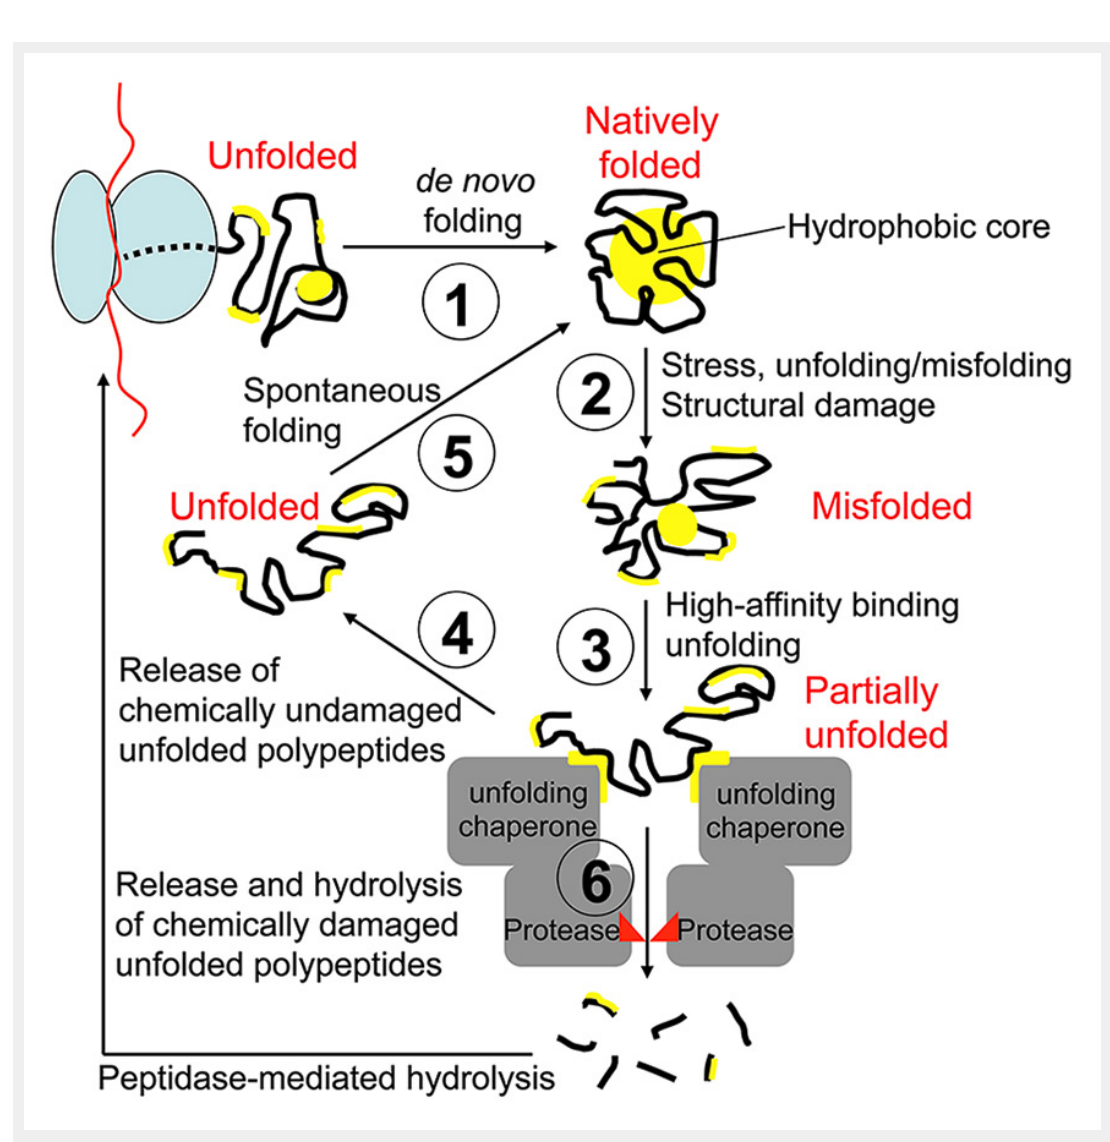
Proteins have an eventful life between birth on the ribosome and death by degradation . Nascent polypeptides with exposed hydrophobic residues (yellow) may spontaneously fold to the native state (step 1) with most hydrophobic residues forming a stable hydrophobic core. Stresses may cause their partial unfolding and misfolding with exposed hydrophobic residues (step 2) that can specifically bind (step 3) the hydrophobic surfaces (yellow) on unfolding chaperones (deep grey) and unfold. Following unfolding some polypeptides can be released (step 4) to spontaneously refold to the native state (step 5). Alternatively, over-sticky unfolded polypeptides can be funnelled into the proteolytic chamber (red triangles) of a protease that is associated with the chaperone (step 6) and degraded into small peptides and by peptidases into amino acids to be reused in de novo protein